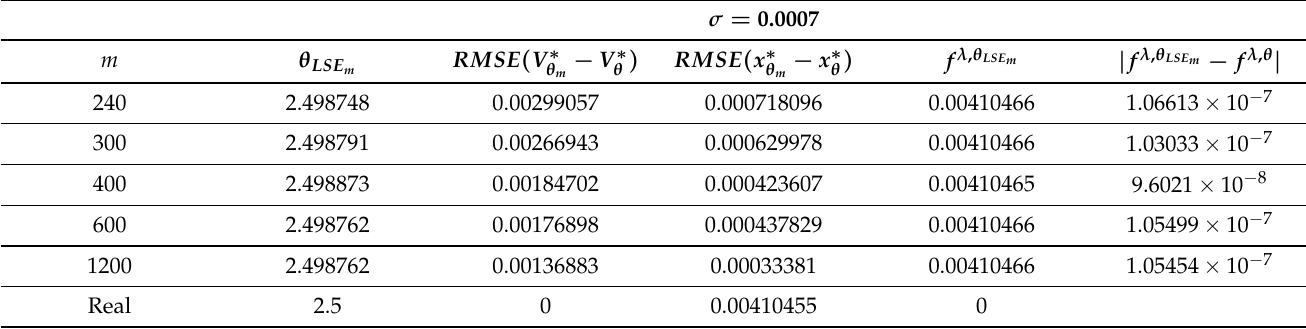
Table 2. RMSE and absolute error between the estimated processes and the real processes ( θ = 2.5) with σ =